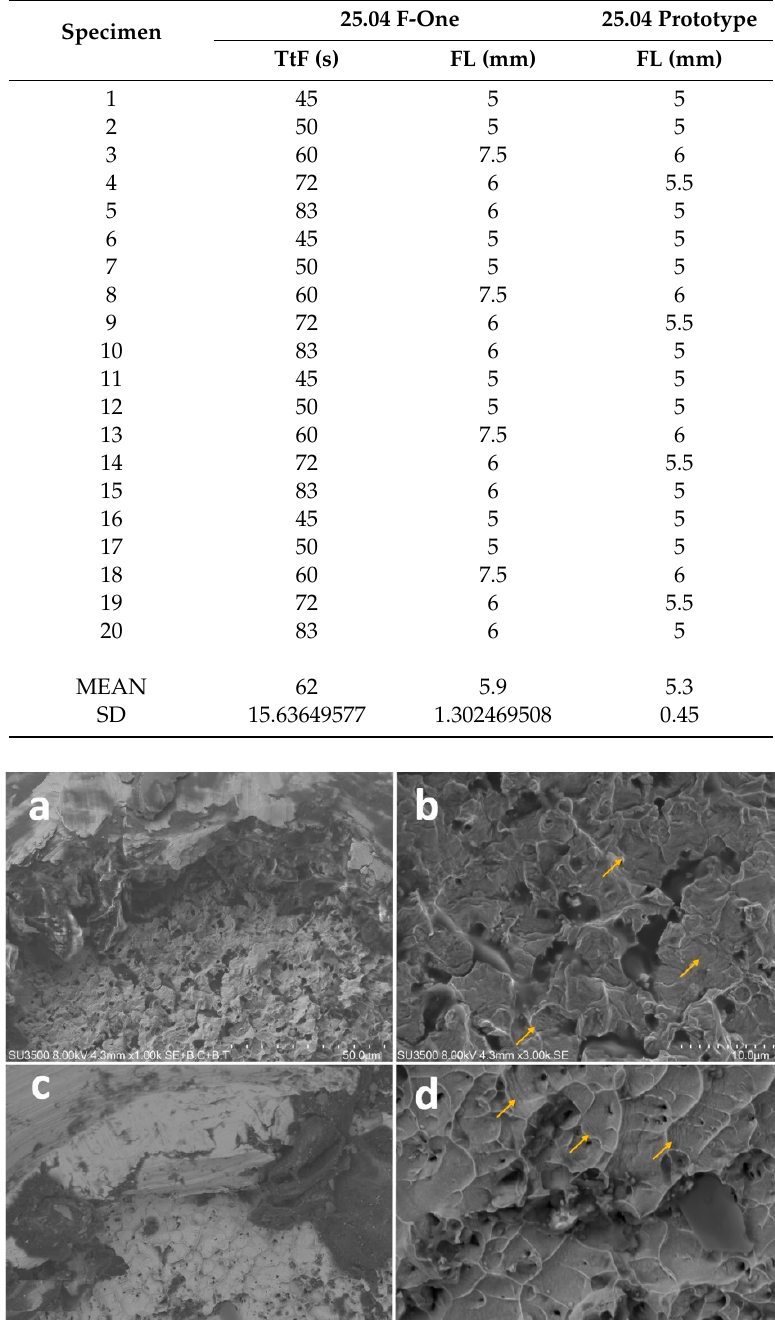
Table 1. Recorded data of the instruments inserted in an 18 mm artificial canal (90 ◦ angle and 5 mm radius) at the speed of 500 rpm. Time to fracture (TtF) and length of the fractured segment (FL), with means and standard deviations.